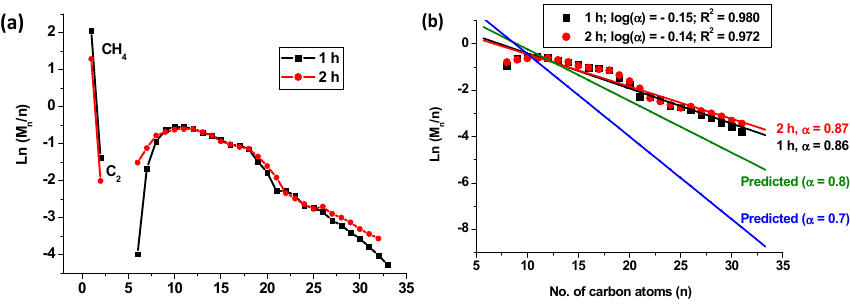
Figure 9. Plots of log(M n / n ) versus n comparing predicted (literature data value) and the measured α -values of Co/C catalyst after 1–2 h on stream, tested at 220 ◦ C, 2 MPa and GHSV = 1800 cm 3 · h − 1 · g − 1